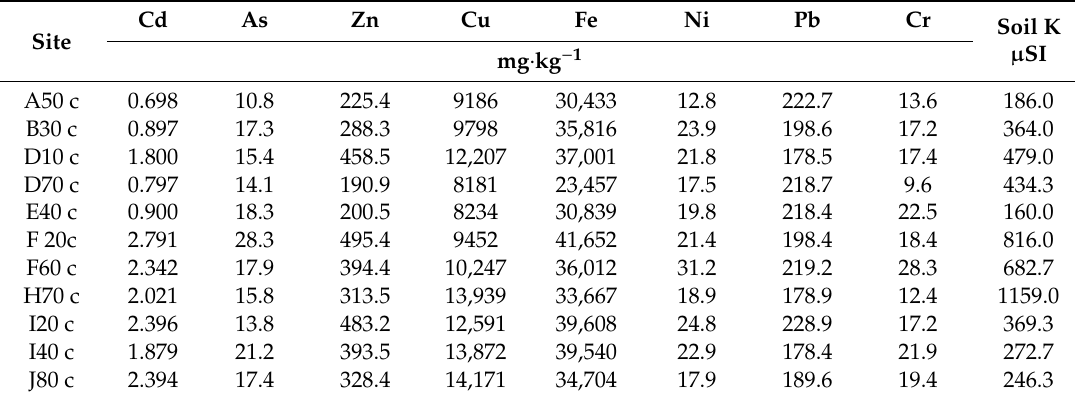
Table 5. Results of chemical analyses for the third stratum at a 20–30 cm